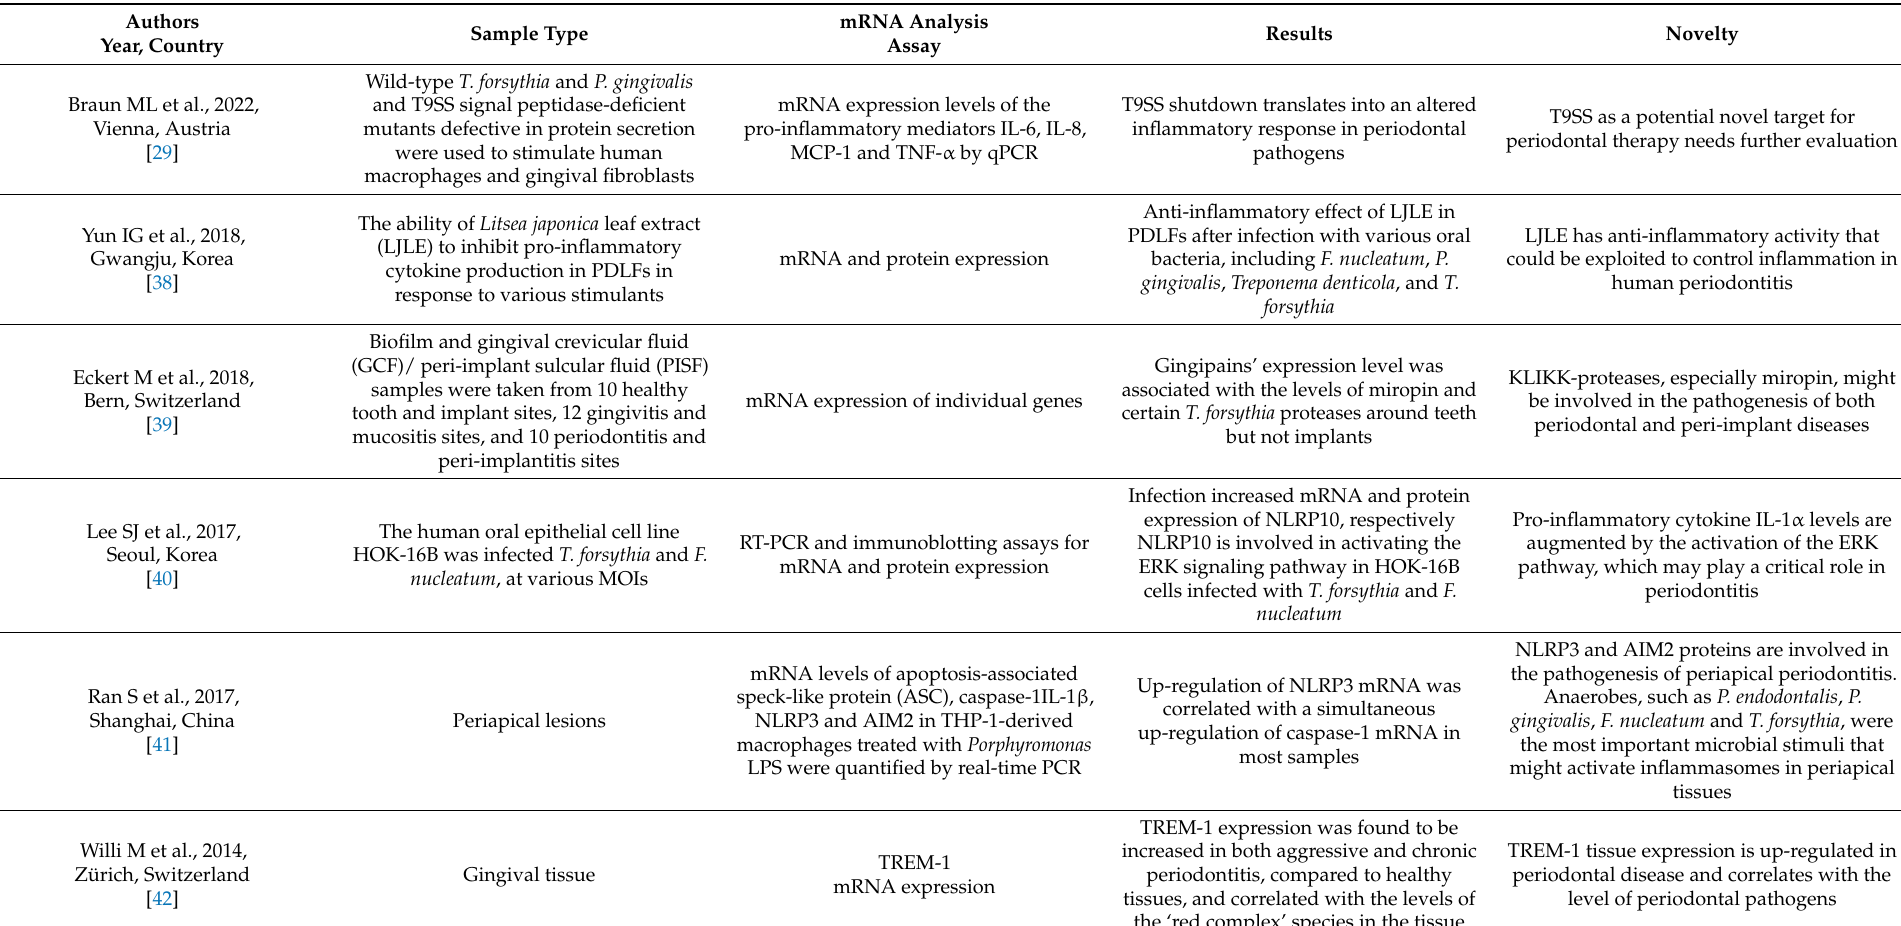
Table 3. Associations between periodontal disease and Tannerella forsythia by mRNA